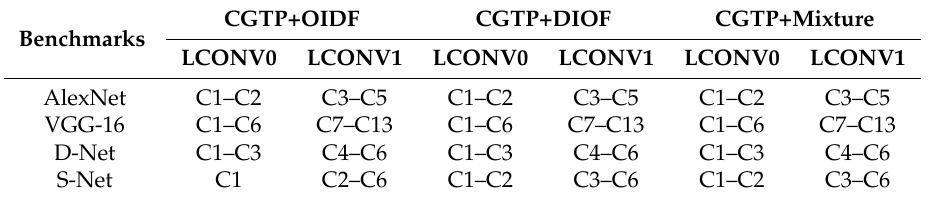
Table 2. Detailed task partitions when applying different dataflows on four benchmarks.